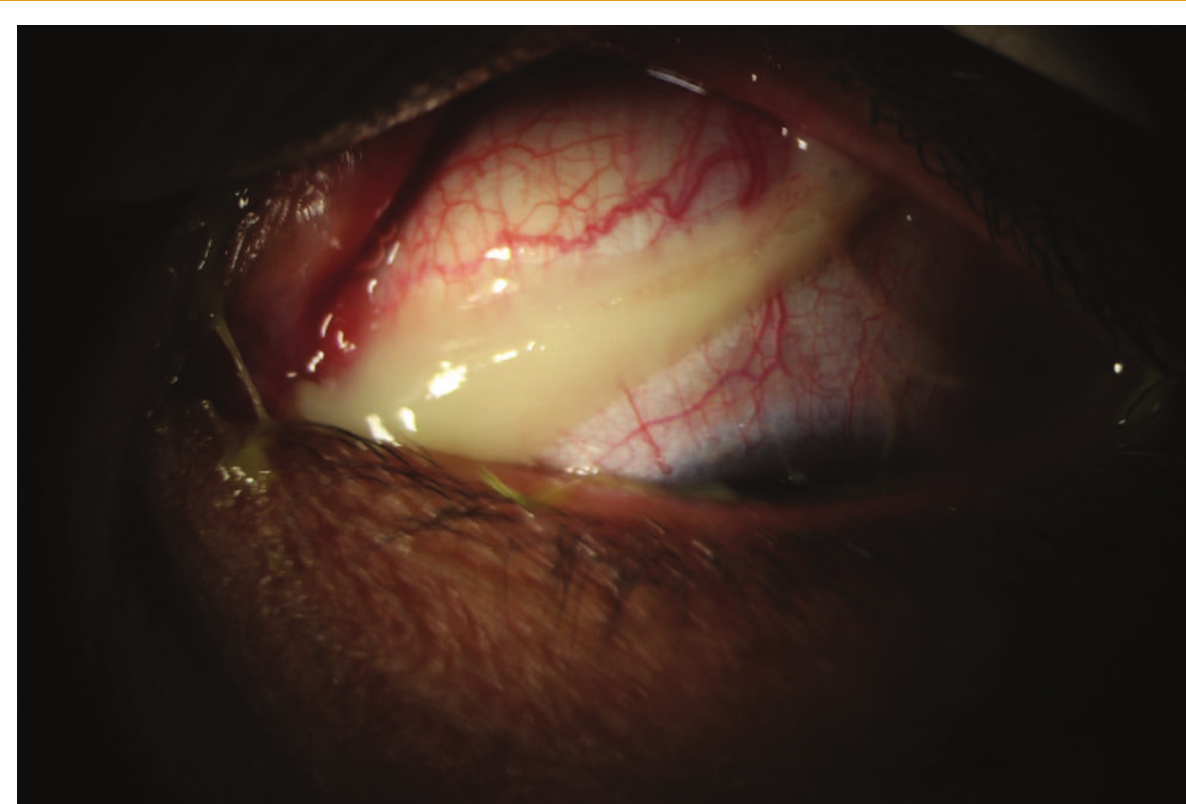
Figure 4. Thick purulent discharge in a patient with acute bacterial